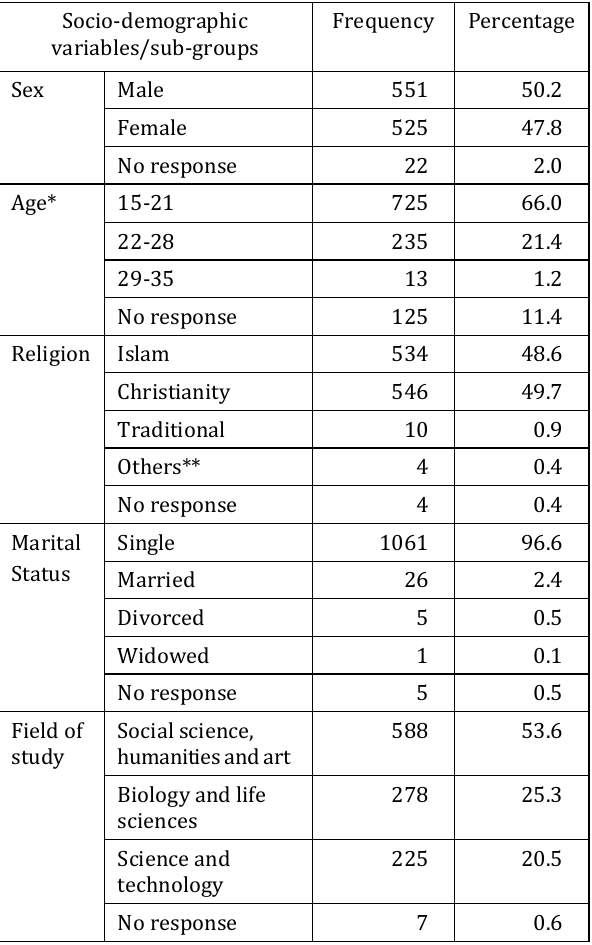
Table 1. Profile of respondents (N =